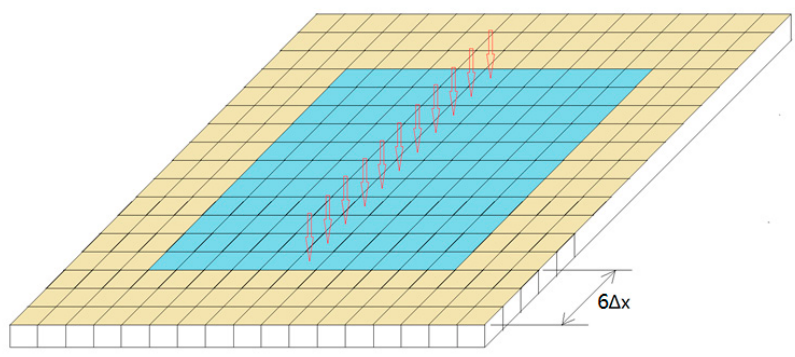
Figure 5. Numerical discretization, loading and fictitious region.